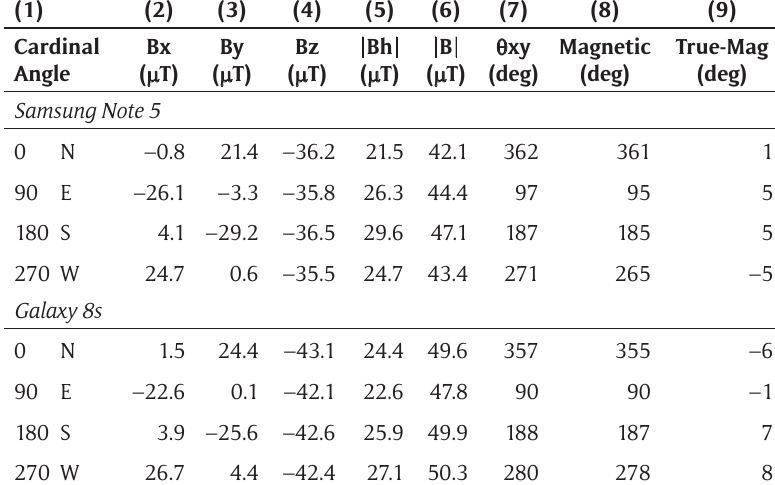
Table 7: Comparison of magnetic bearings with eight Samsung phones.